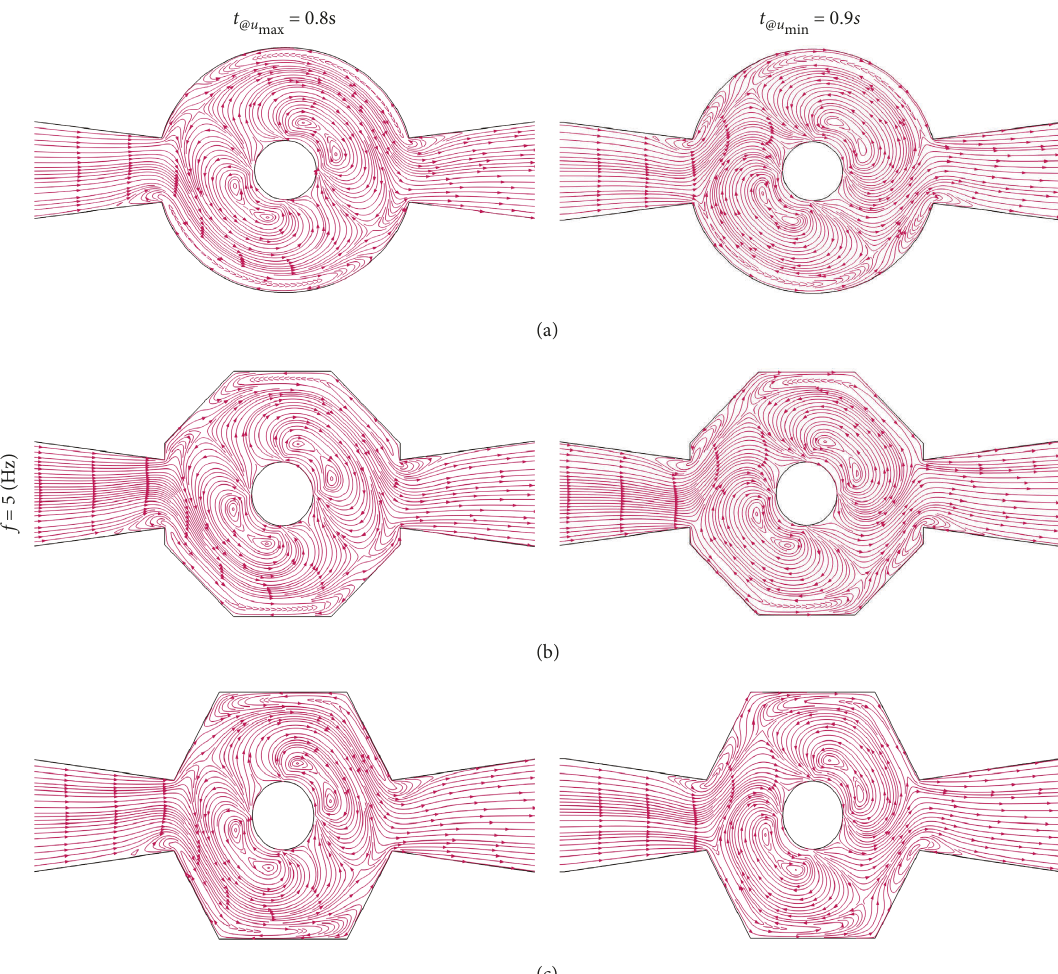
Figure 11: Streamlines in (a) circular, (b) octagonal, and (c) hexagonal mixing chambers for the maximum (left) and minimum (right) velocities in the final cycle at f � 5Hz ( u � 0.1mm · s − 1 , φ � π